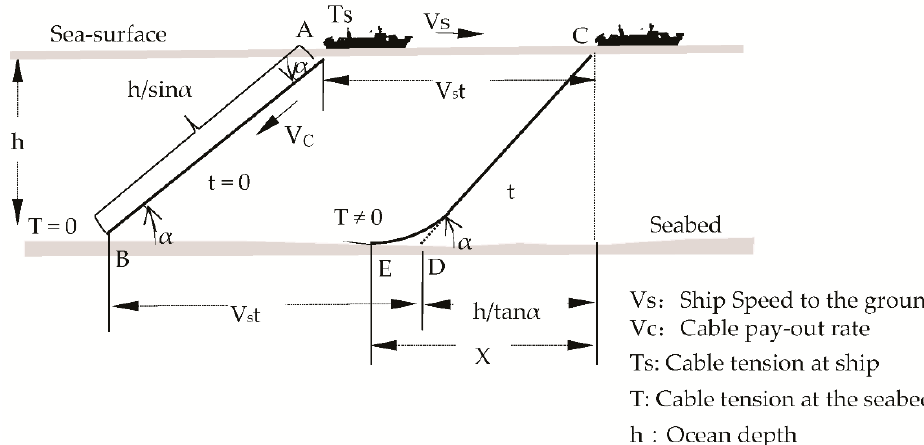
Figure 8. Cable catenary changes in negative slack.